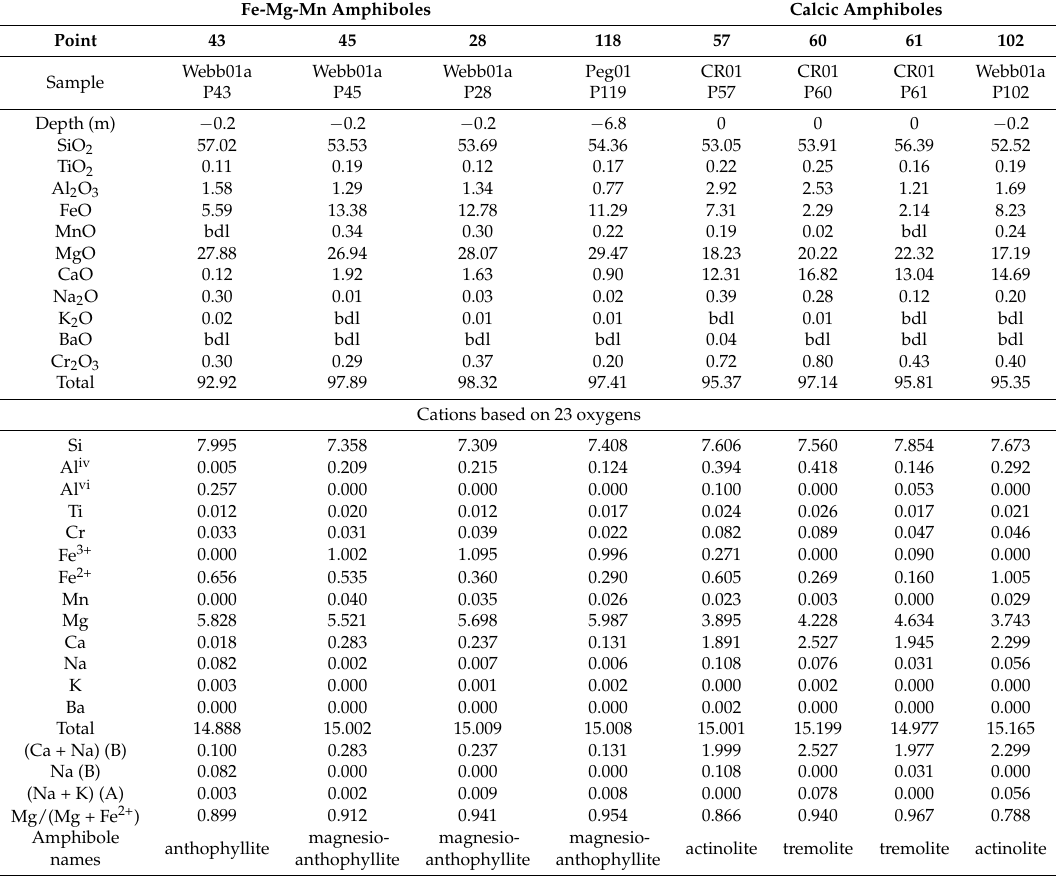
Figure 14. ( a ) Plot of plagioclase An#s versus stratigraphic height of the MSZ for all plagioclase analyses. Corresponding sample locations and lithologies are shown in ( b ). Table 6. Representative amphibole analyses in wt